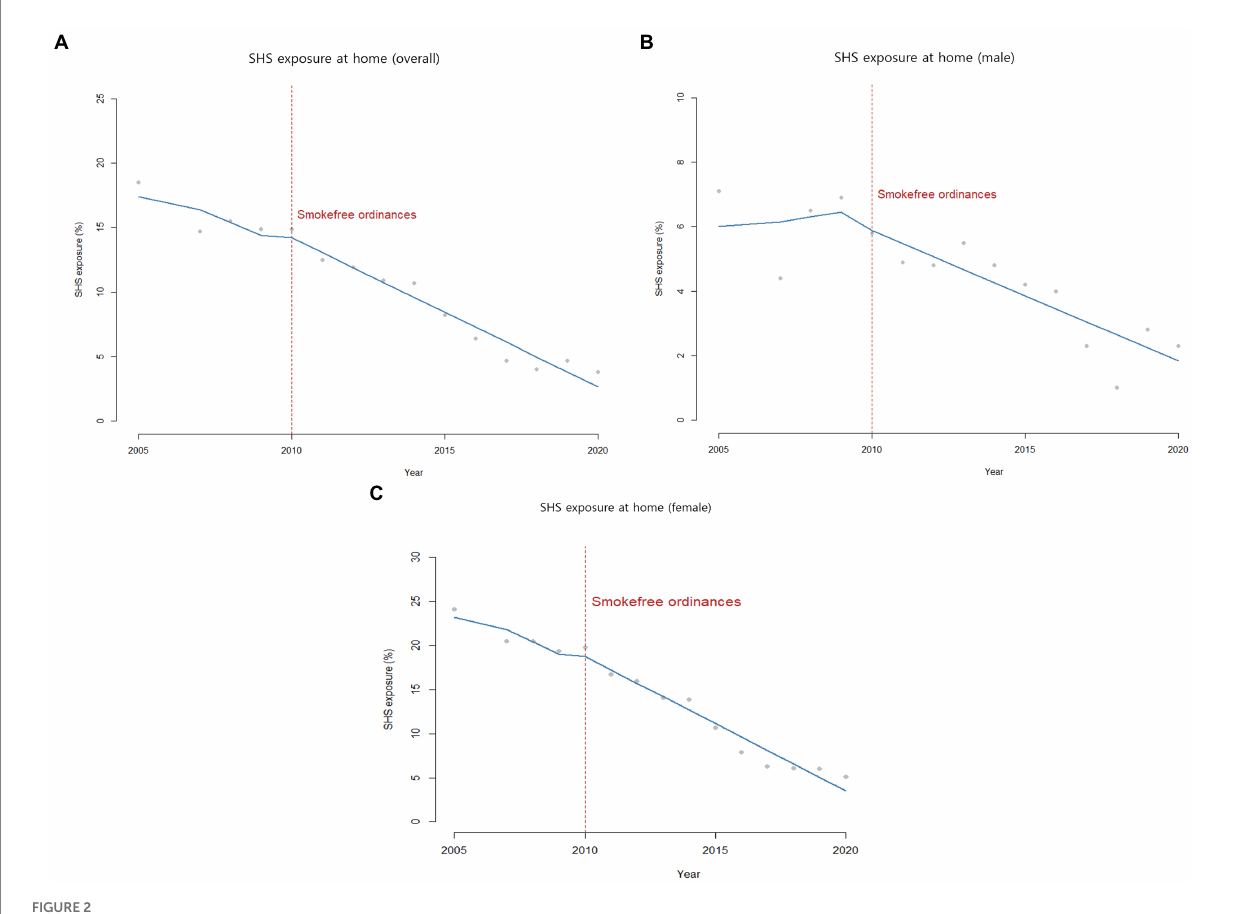
FIGURE 2 SHS exposure at home among adults in ROK